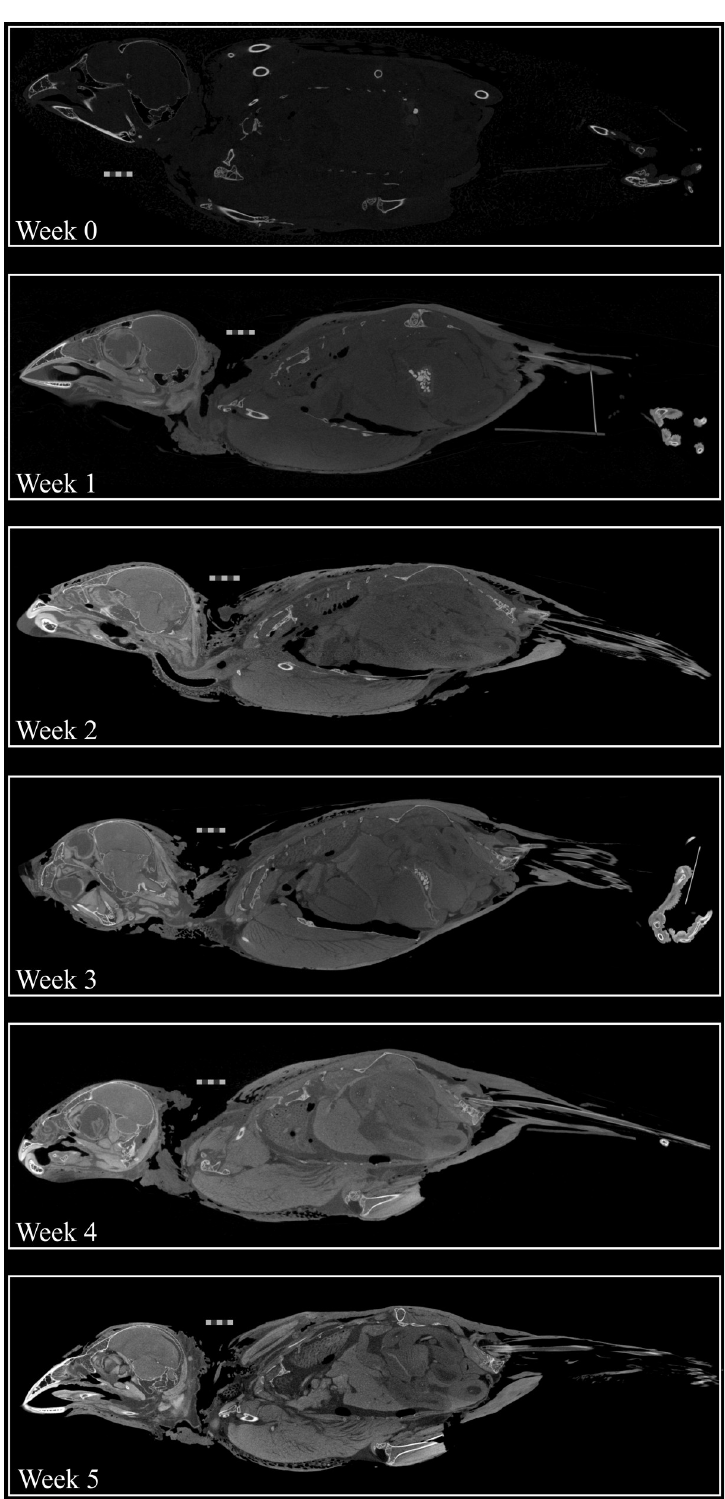
Fig 1. Stain progression over five weeks. Progressive staining of USNM 657963, the specimen stained with I 2 KI in 70% EtOH. The stain can be seen to penetrate deeper into the specimen with every week of staining. Scale bars = 5